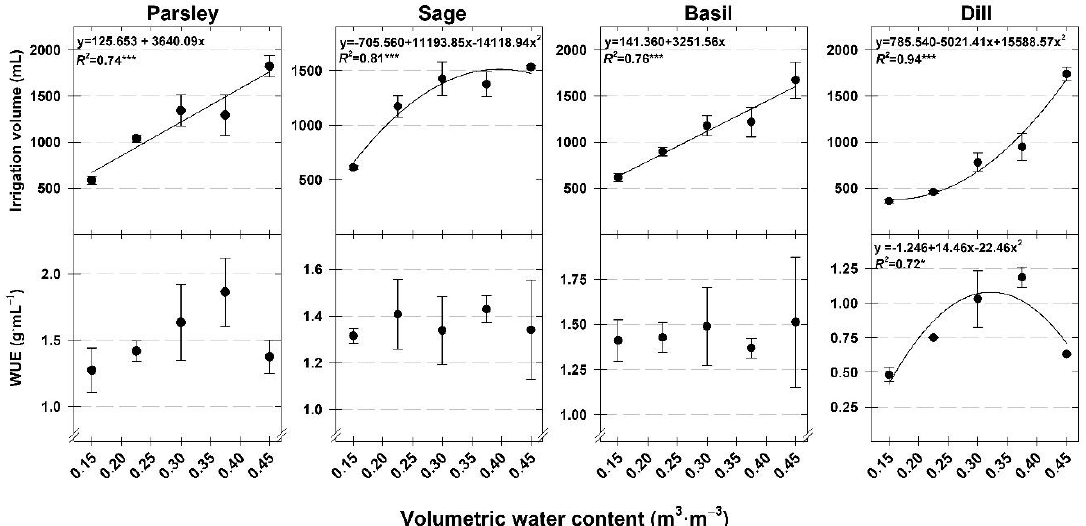
Figure 2. Total irrigation volume and water use efficiency (WUE) for parsley and sage (Expt. 1) and basil and dill (Expt. 2) grown in 11.4 cm diameter containers filled with a soilless substrate comprising (by vol.) 75% sphagnum peat moss and 25% coarse perlite amended with 3.0 kg·m − 3 controlled-release fertilizer and maintained at 0.15, 0.23, 0.30, 0.38, or 0.45 m 3 ∙m − 3 substrate volumetric water content for four weeks. Regression lines are presented for significant correlations only with corresponding R 2 presented. * and *** indicate significant at p ≤ 0.05 or 0.001, respectively.